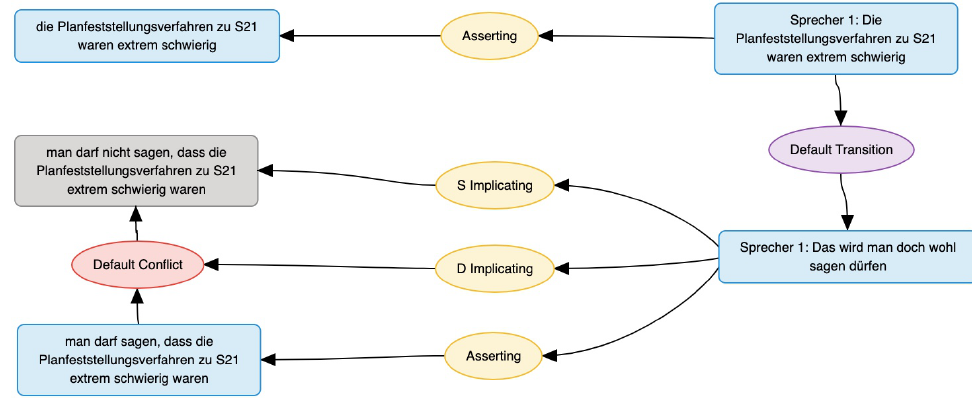
Figure 3. IAT CI diagram for Example (13).